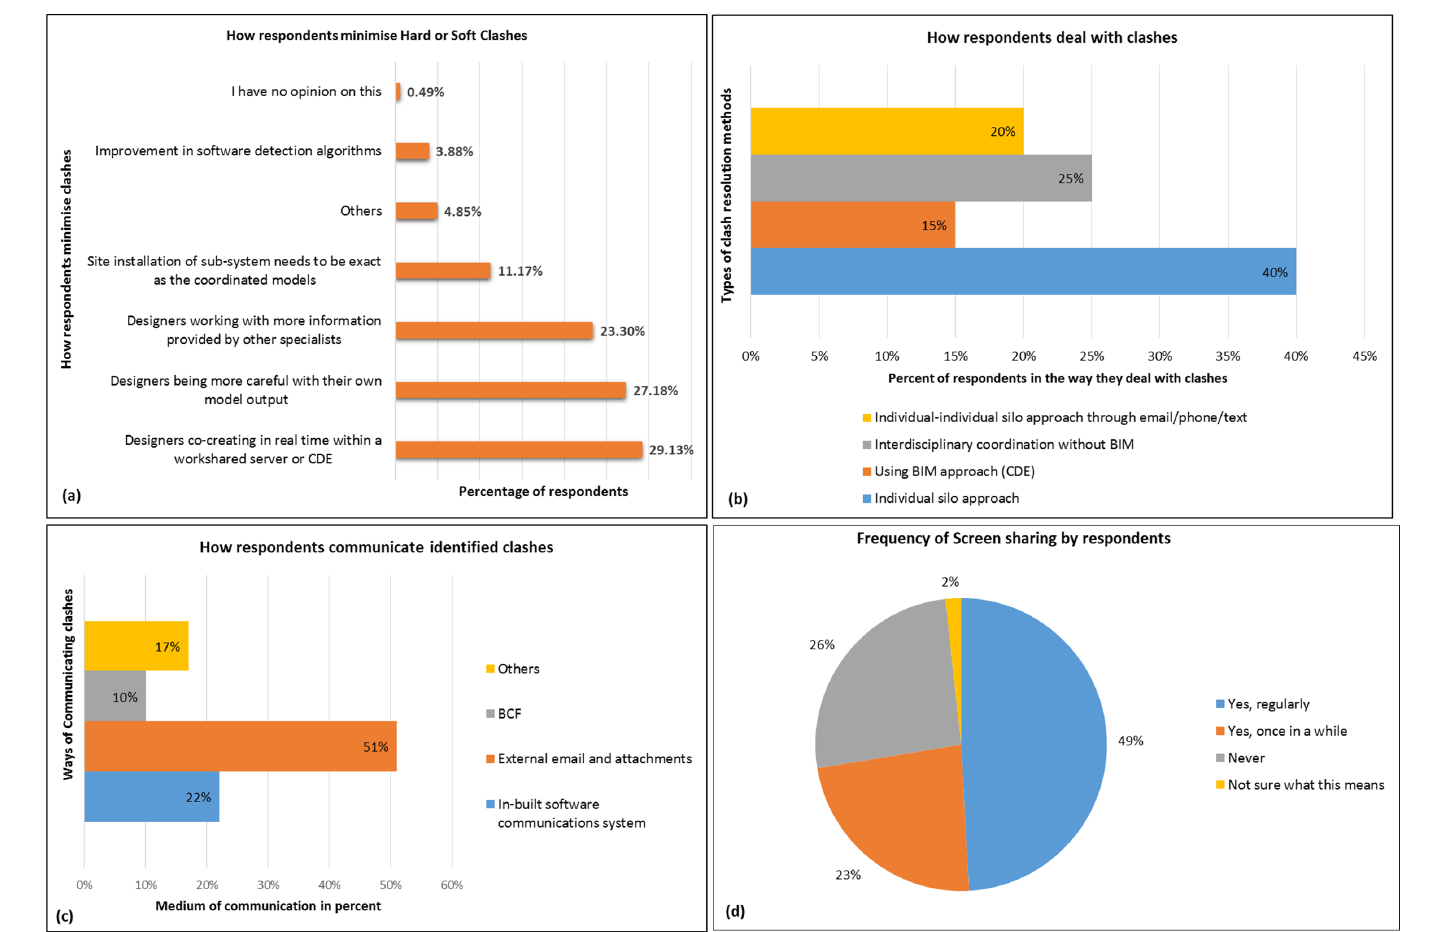
Figure 4. Respondents’ views on how clashes are resolved.